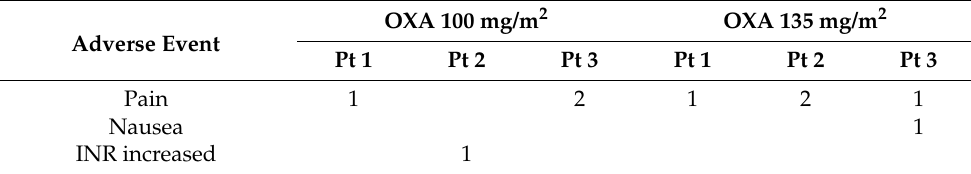
Table 3. Adverse events (CTCAE 4.03) according to dose level of Oxaliplatin.